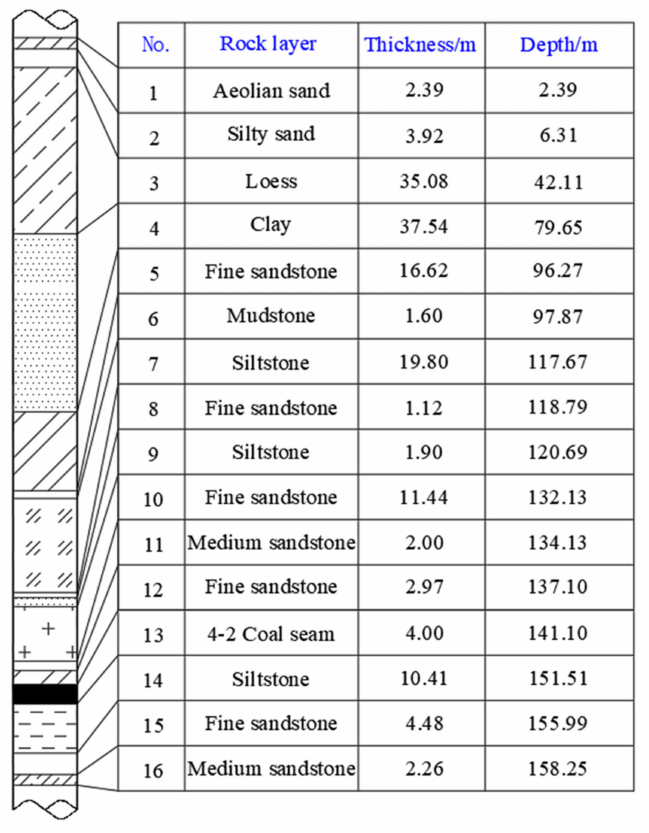
Figure 1. The study coal mine location and geological conditions. ( a ) Location of Liangshuijing coal mine and panels layout in the 421 mine area; ( b ) The mining conditions of 42,115 panel and adjacent panel.